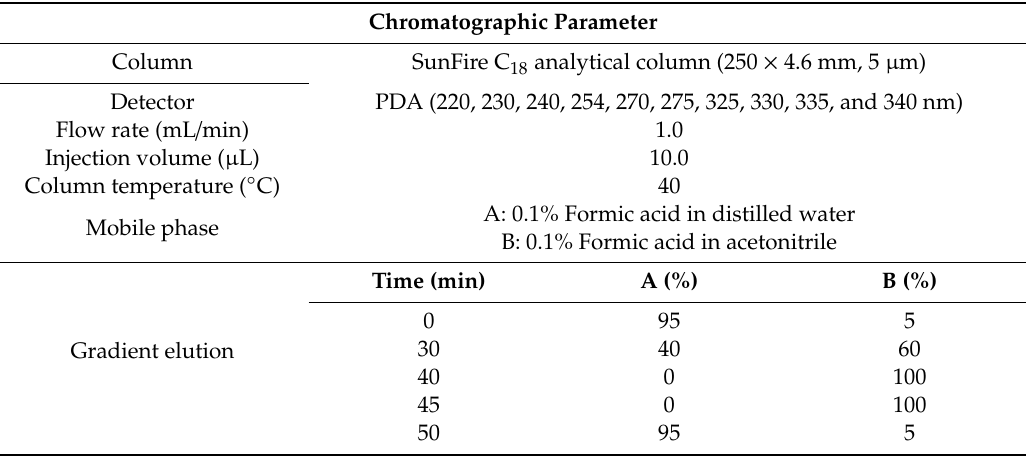
Table 2. Chromatographic parameters for high-performance liquid chromatography (HPLC) analysis of 18 marker components in